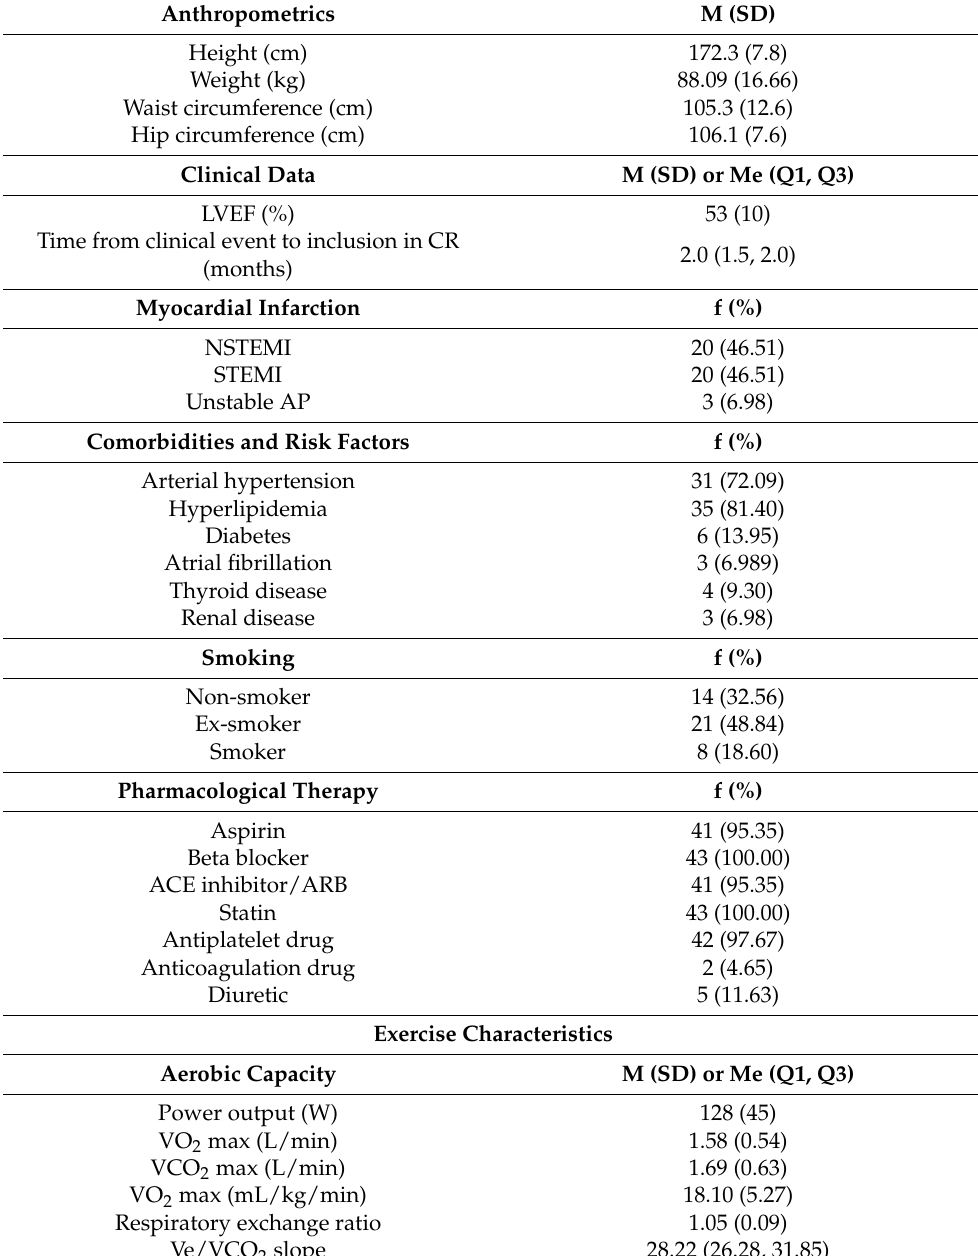
Table 1. Demographics, comorbidities, pharmacological therapy, cardiovascular risk factors, and exercise